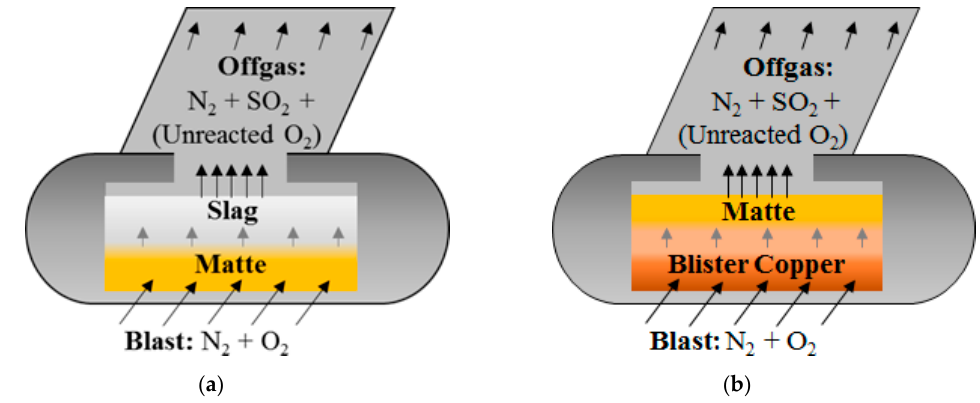
Figure 4. Cross-section of a Pierce-Smith converter, during ( a ) a slag-blow and ( b ) a copper-blow.